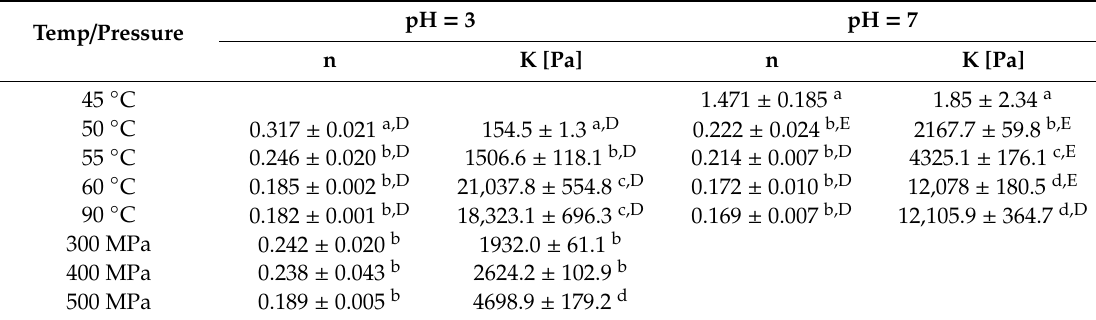
Table 1. The slope (n) and constant (k) of the mechanical spectrum fitting to Equation (2) of the thermally and pressure induced